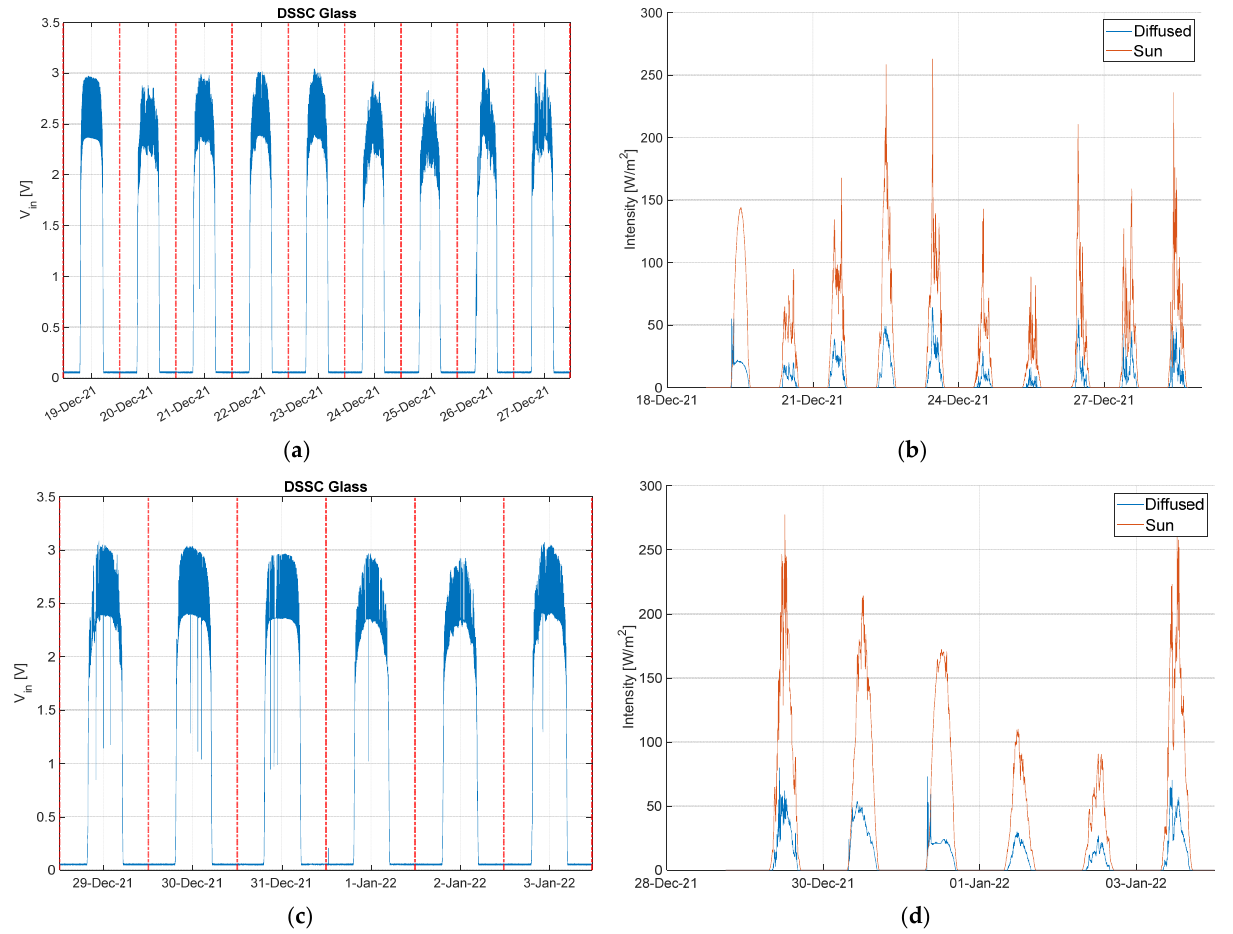
Figure 6. The acquired Li ‐ Po battery voltages in the case of glass and flexible DSSC energy harvest ‐ ing during the first test campaign (( a , b ), respectively) and the second test campaign (( c , d ), respec ‐ tively).